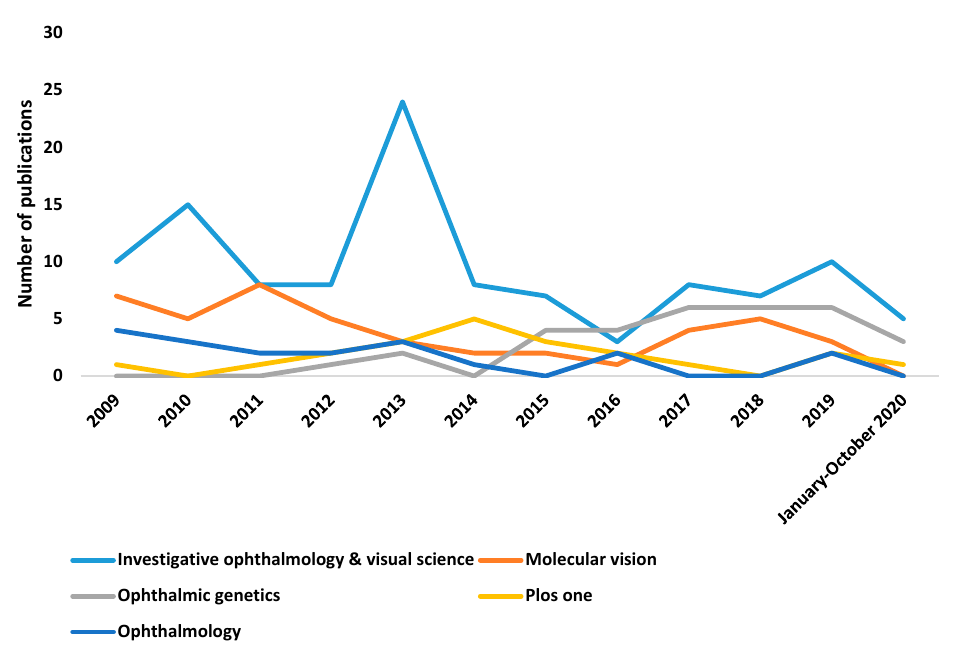
Figure 5. Number of publications per journals and year. Table 6. The 30 most used